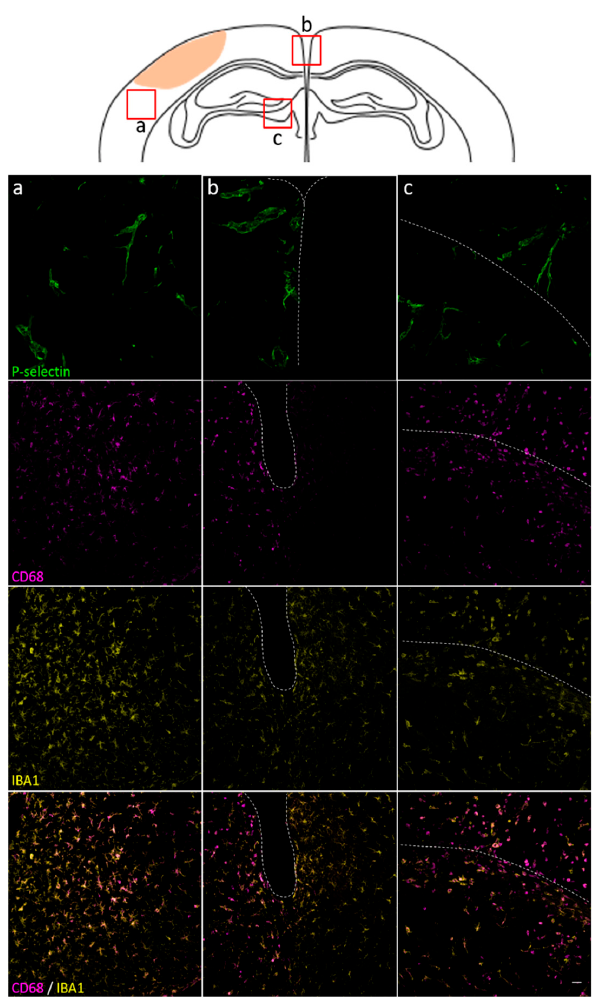
Figure 5. Spatial distribution of microglia / macropahges in relation to P-selectin at 2 days post-TBI. Representative micrographs of P-selectin, CD68, IBA1, and CD68 / IBA1 in ipsilateral cortex ( a , b ) and hippocampus – thalamus ( c ). The white dotted line defines the border between the hippocampus (upper part of the image) and the thalamus (lower part of the image), as shown in the sketch. TBI induced an increase in P-selectin and CD68 in matched regions and was selectively present in the ipsilateral hemisphere (see also Supplementary Figure 2). Scale bar 50 µm.